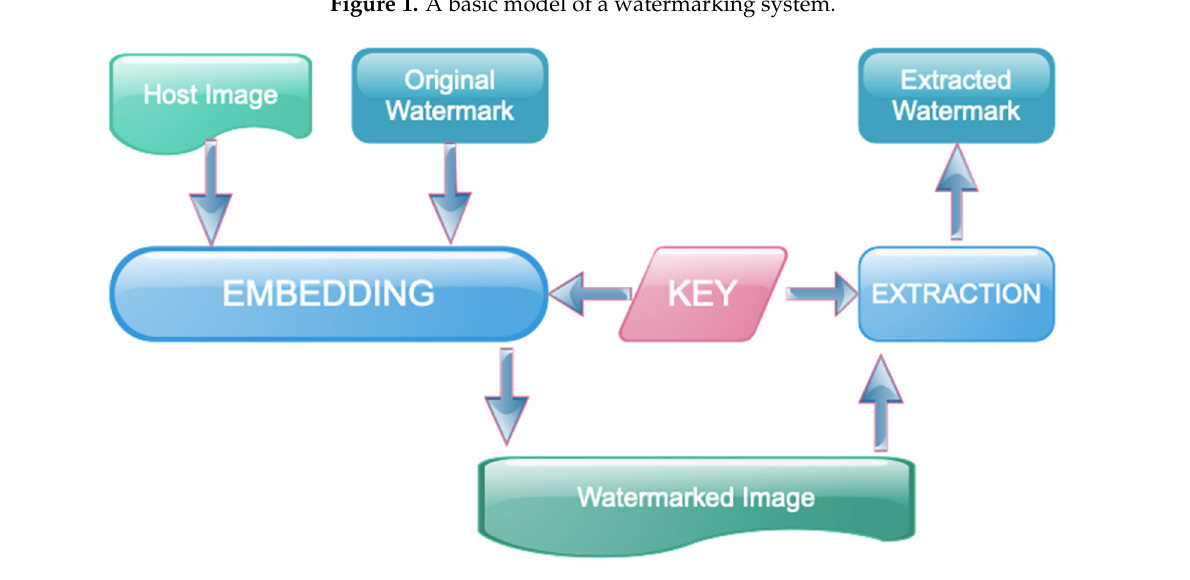
Figure 2. Block diagram of the watermarking process.